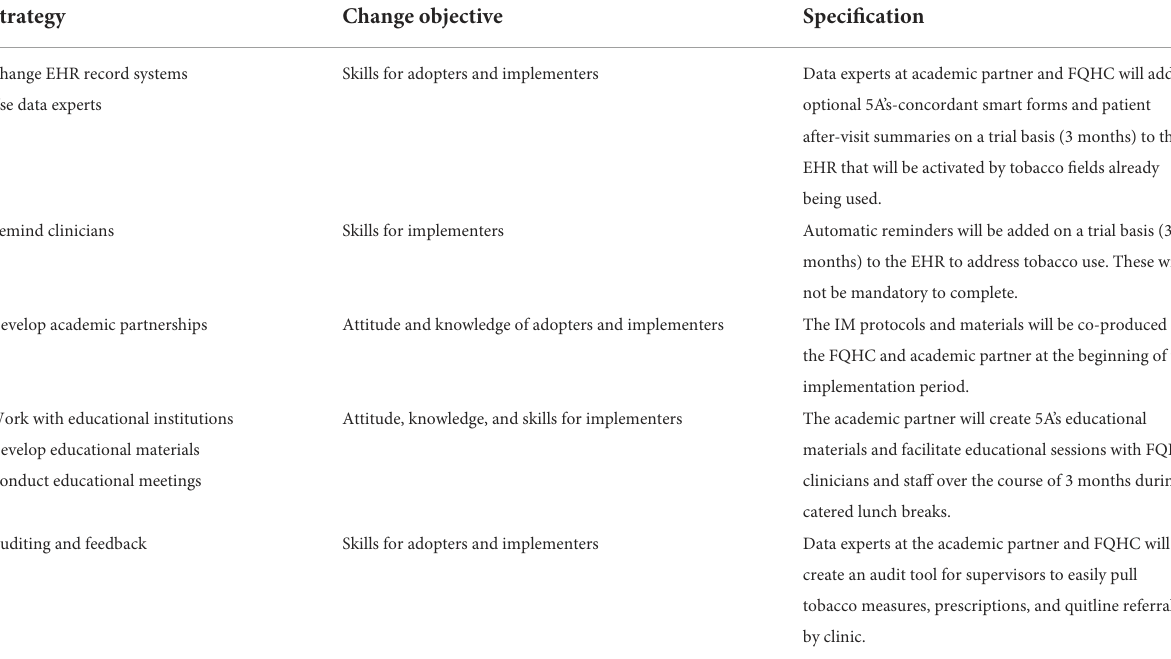
TABLE 4 Implementation strategies generated by implementation